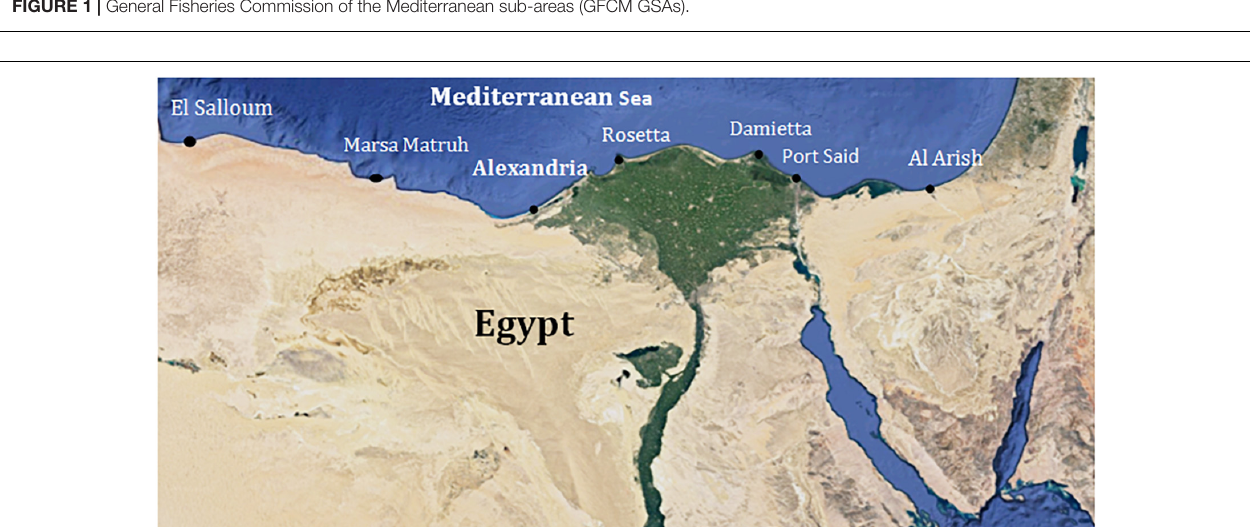
FIGURE 1 | General Fisheries Commission of the Mediterranean sub-areas (GFCM GSAs).